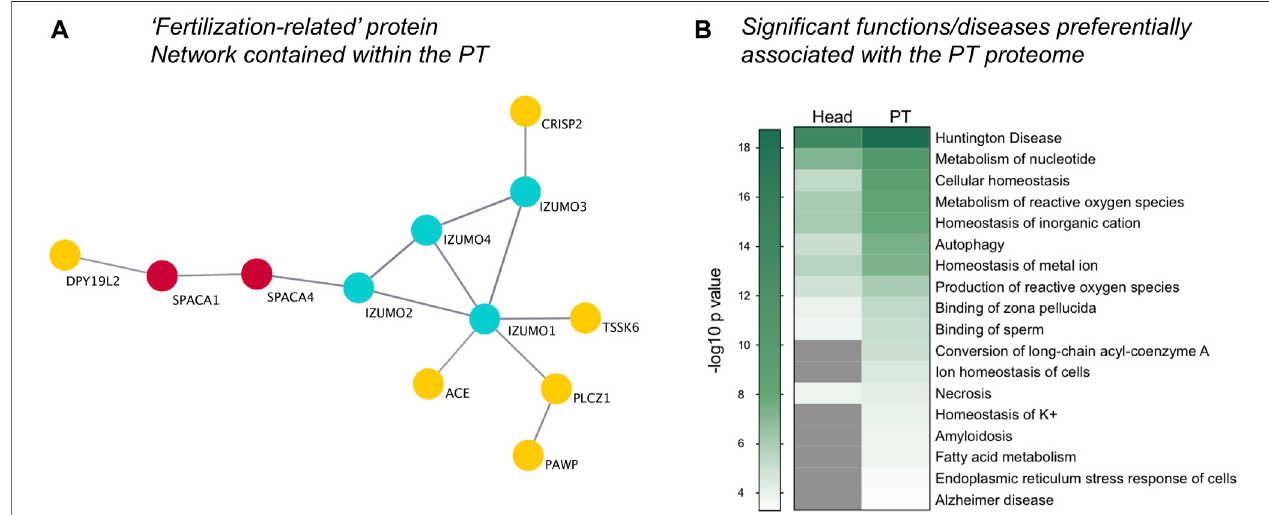
FIGURE 6 | Visualization of fertilization-related proteins and functional pathway analysis. Within the whole PT proteome, a distinct protein cluster comprising key proteins involved in fertilization was detected through String protein network analysis and visualized using Cytoscape (A) . (B) Ingenuity Pathway Analysis software revealed the key diseases and functions enriched within the PT compared to the sperm head ( − log10 p -value ≥ 1.3; p -value ≤ 0.05), featuring diseases with a basis in protein misfolding and functions related to the endoplasmic reticulum stress response, cellular homeostasis and fertilization, including “ Binding of sperm ” and “ Binding of zona pellucida. ” Grey indicates no signi fi cant value.